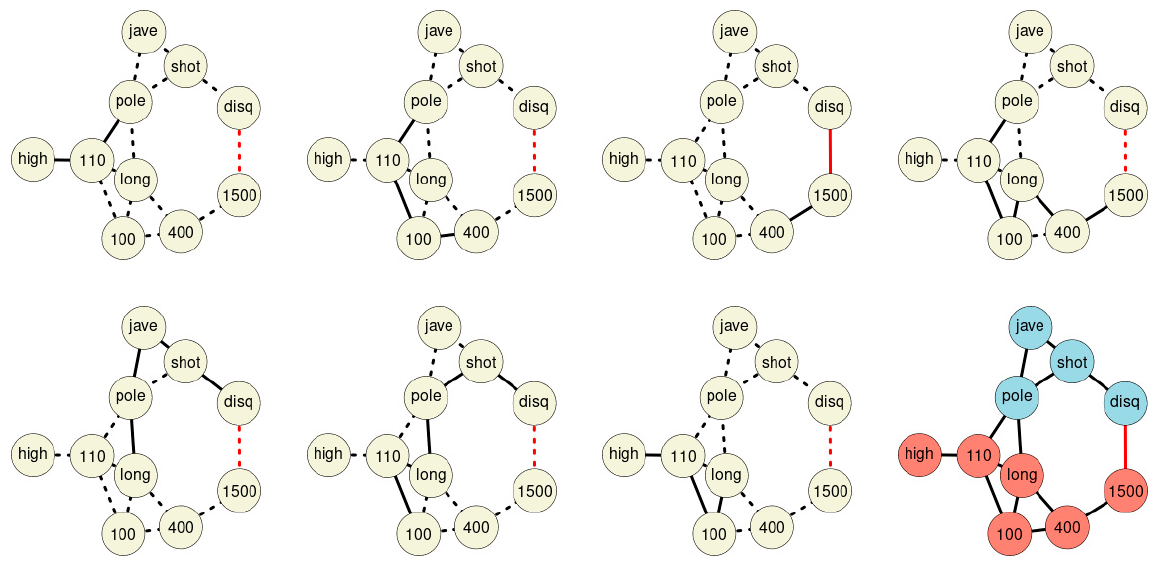
Figure 4. The seven association chains of sample 1. The final St. Nicolas House graph is depicted in the lower right corner. Blue nodes represent disciplines involving upper parts of the body, red nodes disciplines focus on the lower part of the body. Black edges indicate positive, red edges indicate negative correlations.